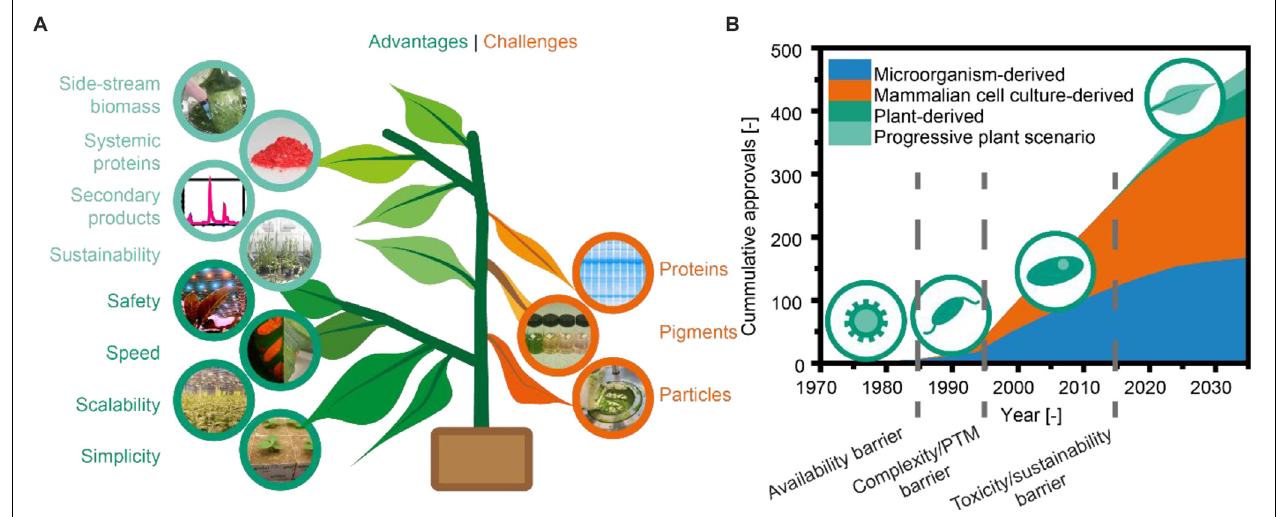
FIGURE 1 | Overview of plant-based expression systems. (A) Advantages and challenges typically encountered during plant molecular farming. This study expands the previously reported aspects (dark green and orange) with new potential benefits (light green). (B) Approvals of recombinant-protein-based biopharmaceuticals. Starting in 1985, the approved drugs expressed in microorganisms (prokaryotic and eukaryotic), mammalian cells, or plant cells are plotted in 5-year intervals based on data published up to 2014 (Walsh, 2014). The forecast up to 2035 is based on reported product pipelines (e.g., Gleba et al., 2014).